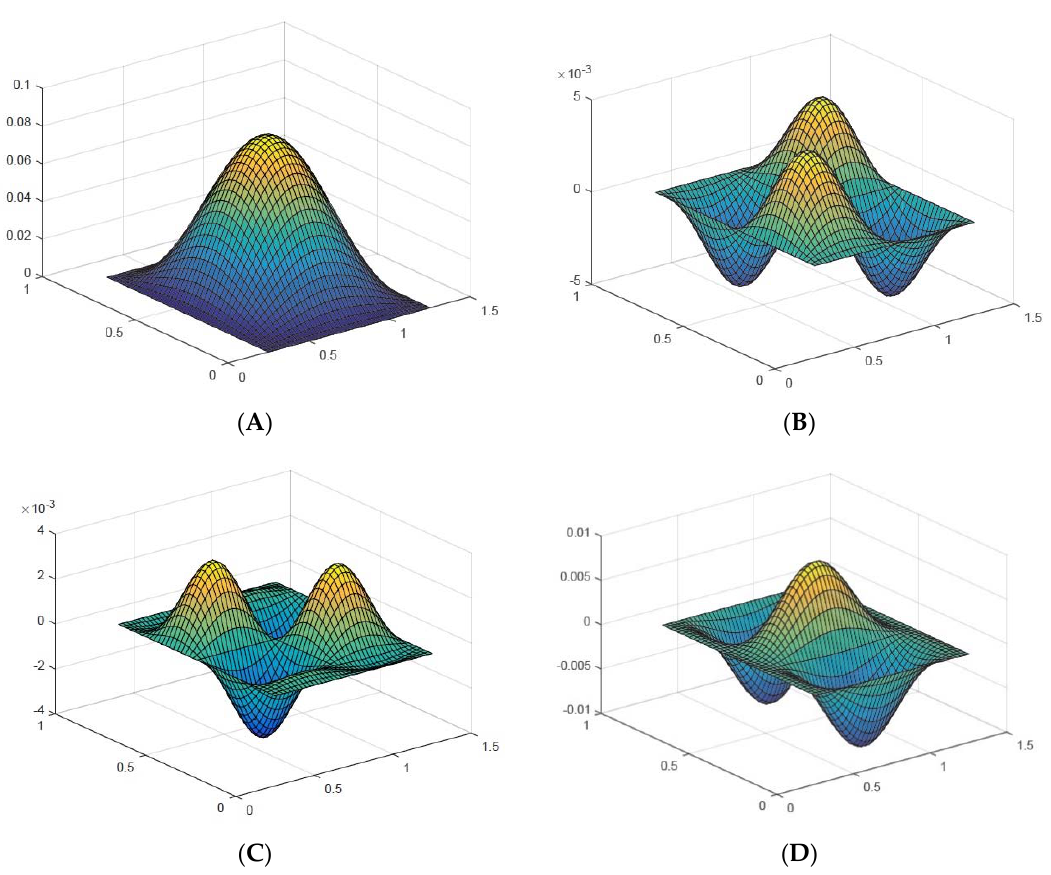
Figure 4. The free vibration mode shapes of a SSSS square FG-V CNT-reinforced rhombic plate for skew angle 30 ◦ ( A ) 1st Mode; ( B ) 2nd Mode; ( C ) 3rd Mode and ( D ) 4th Mode. Table 14. Variation of non-dimensional maximum deflection of FG-CNT-reinforced simply supported rhombic plate under uniform